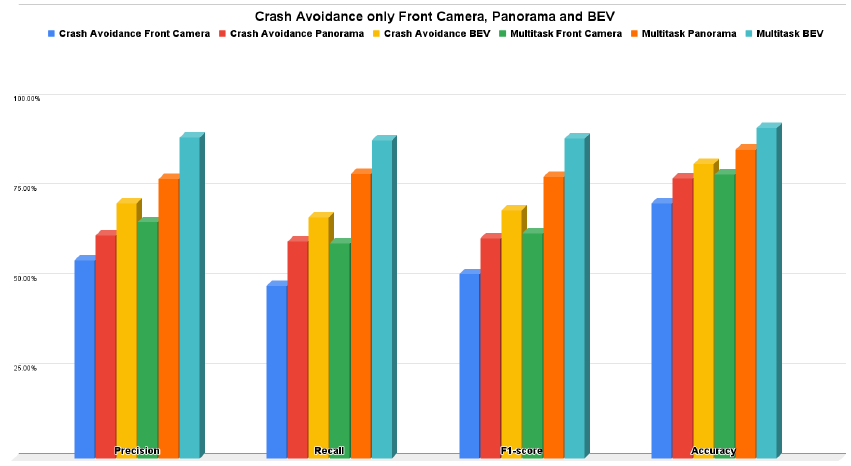
Figure 14. Precision, recall, f1-score, and accuracy for crash avoidance only vs.